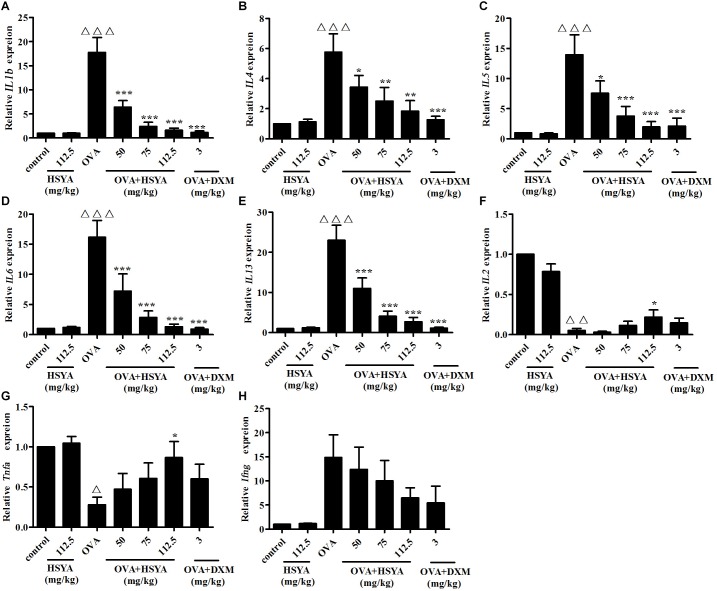
Effects of HSYA on IL1b
(A), IL4
(B), IL5
(C), IL6
(D), IL13
(E), IL2
(F), Tnfa
(G), and Ifng
(H) mRNA levels in lung tissue in guinea pigs. Data presented as mean ± SD. ∆
p < 0.05, ∆∆
p < 0.01, ∆∆∆
p < 0.001 versus normal control group, ∗p < 0.05, ∗∗p < 0.01, ∗∗∗p < 0.001 versus OVA group.